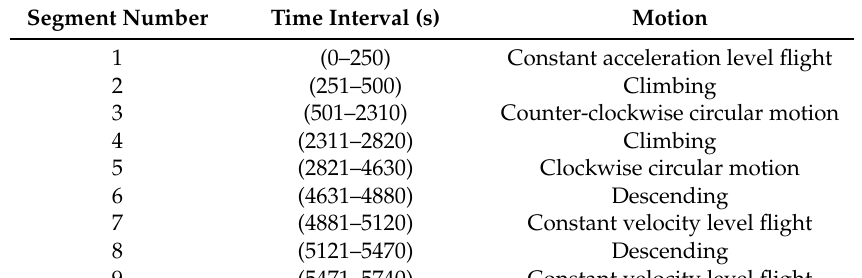
Figure 10. Three - dimensional vehicle trajectory for Scenario 2. Table 6. Description of the vehicle motion for Scenario 2. Table 6. Description of the vehicle motion for Scenario 2.